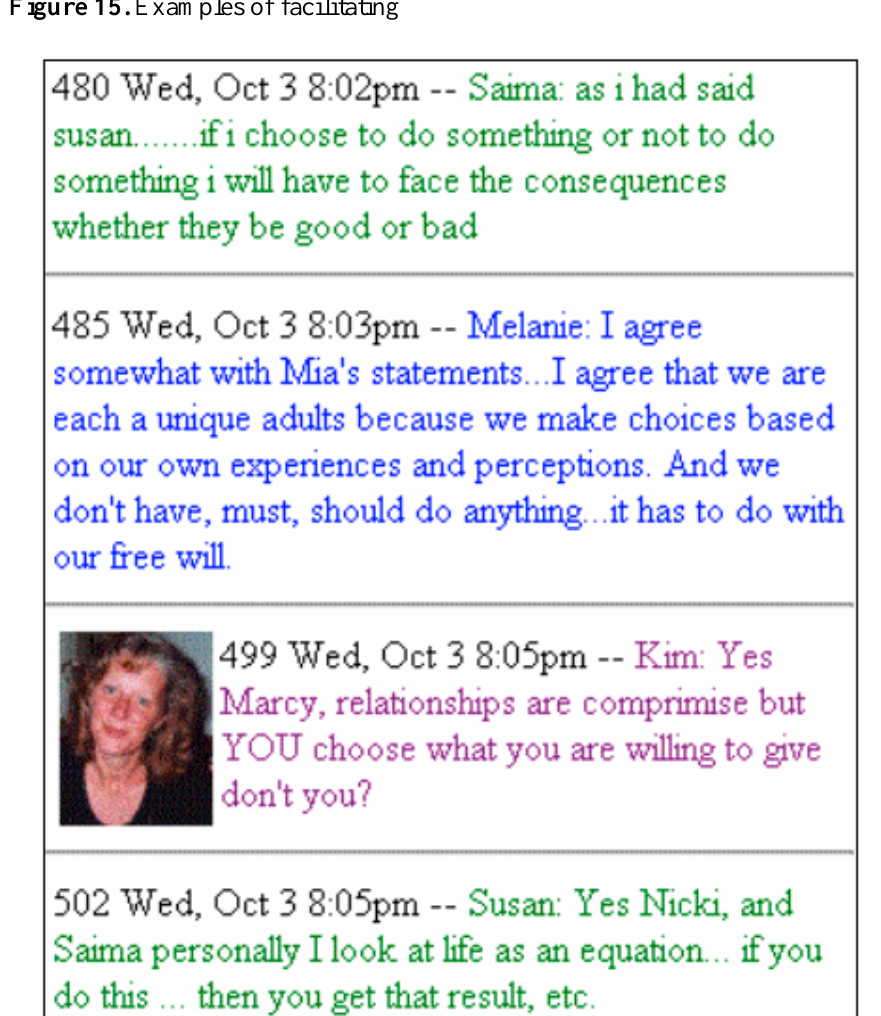
Figure 15. Examples of